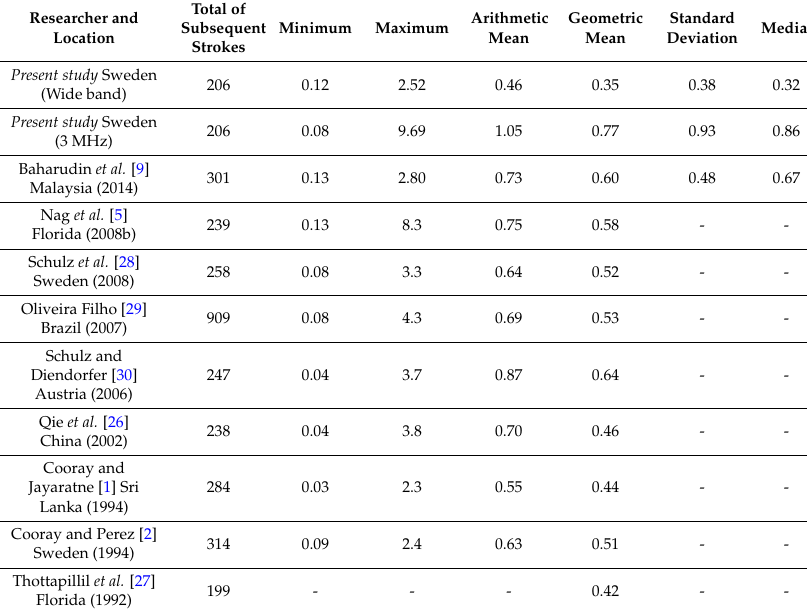
Table 6. Subsequent return strokes (SRS) to RS